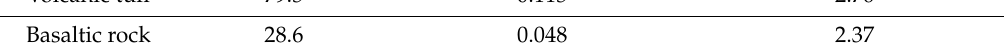
Table 2. Structure parameters of volcanic tu ff and basalt from Ivanodolinsky quarry [25]. Material